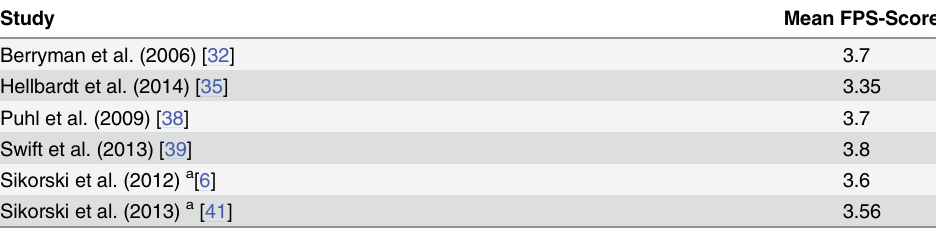
Table 2. Average FPS-Scores.